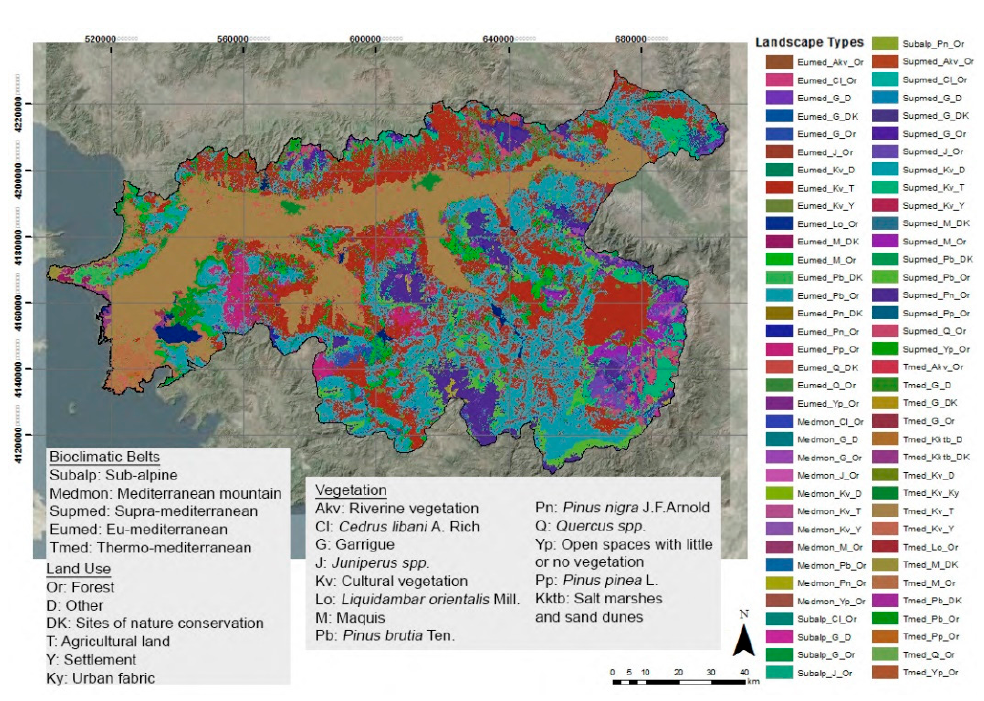
Figure 6. The spatial distribution of the landscape types.